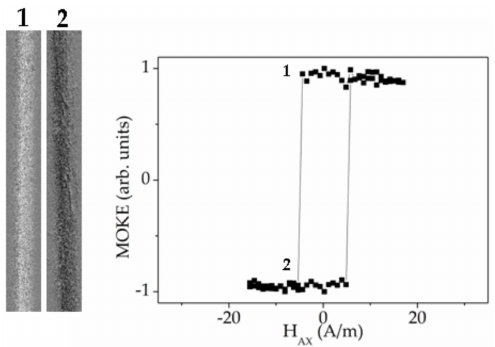
Figure 17. MOKE hysteresis loop and images of surface domain structure obtained in as-prepared sample № 5 in the presence of torsion stress of 2 π rad m −